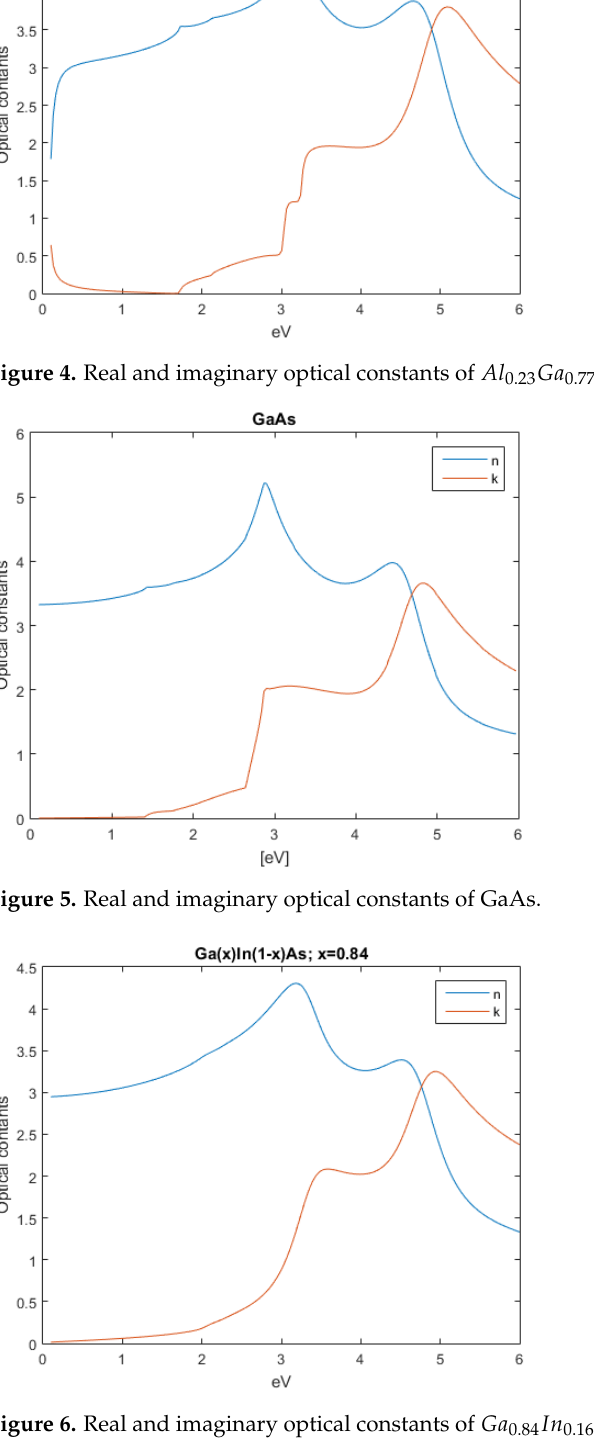
Figure 6. Real and imaginary optical constants of Ga 0.84 In 0.16 As